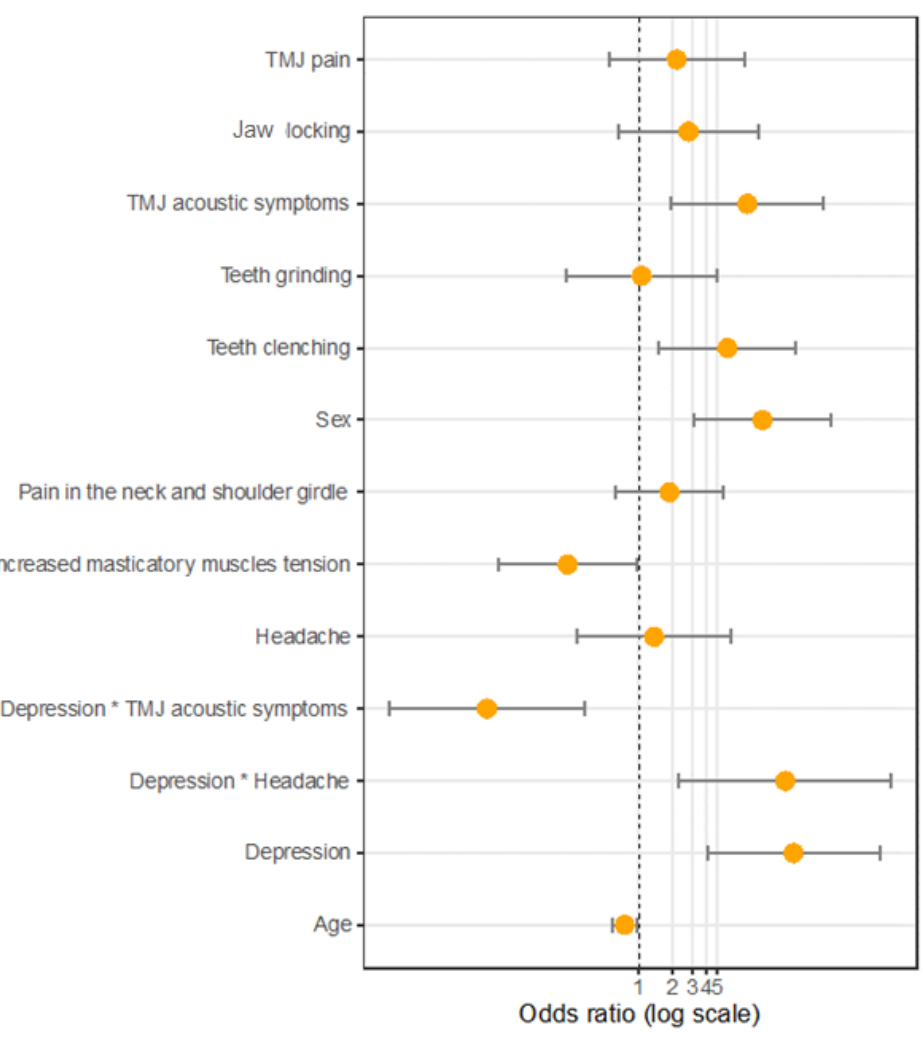
Figure 1. Customized model of the odds ratios.